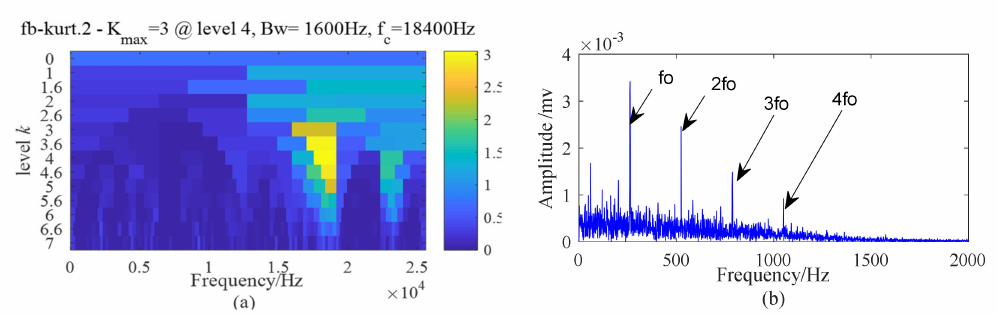
Figure 29. The diagnosis result of the collected signal of bearing with 3 mm outer race fault processed by the Fast Kurtogram (FK) method: ( a ) the kurtogram result; ( b ) the squared envelope spectrum result.